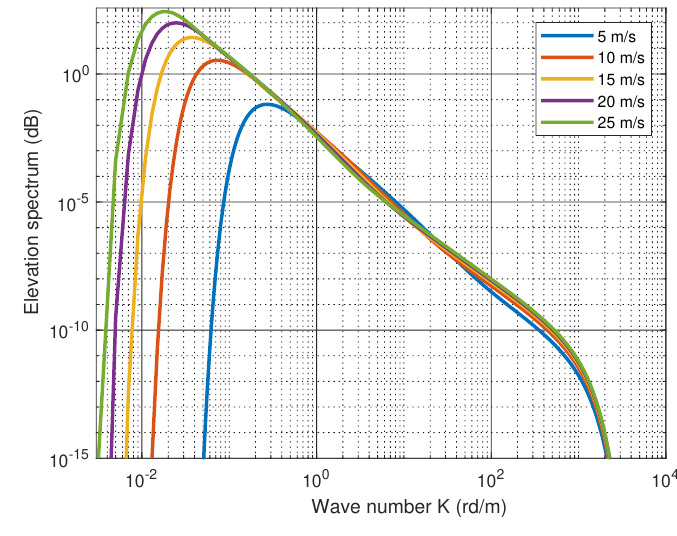
Figure 8. Elfouhaily elevation spectrum.